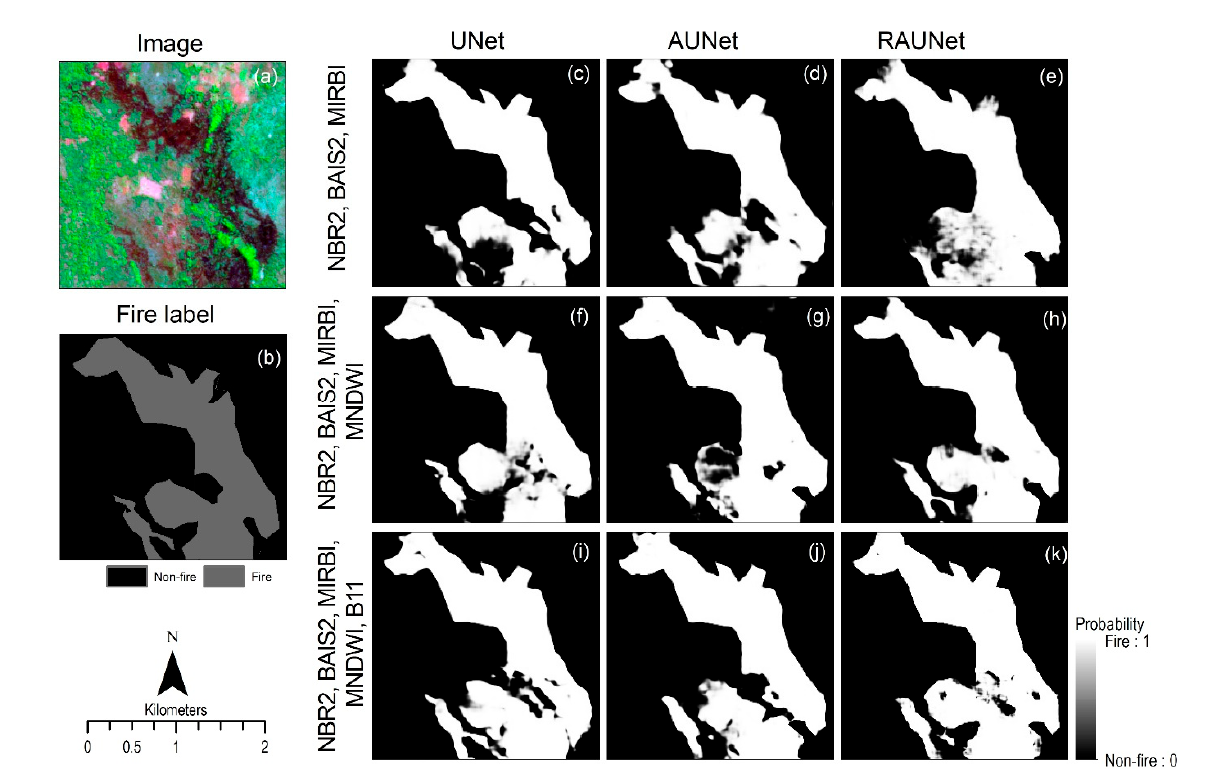
Figure 7. The predicted burned areas using three datasets and three trained deep-learning-based models, including UNet, attention UNet (AUNet), and residual attention UNet (RAUNet), within ( a ) an image-patch with ( b ) fire labels. The prediction of fires using ( c – e ) the top three Sentinel-derived variables, ( f – h ) the top four variables, and ( i – k ) the top five variables with each of the three models. Table 2. The accuracy of the trained UNet, attention UNet (AUNet), and residual attention UNet (RAUNet) using three datasets generated from the top five derivatives of Sentinel-2 data (i.e., NBR2, BAIS2, MIRBI, MNDWI, and B11) to identify the burned areas from the non-burned areas in miombo woodlands.